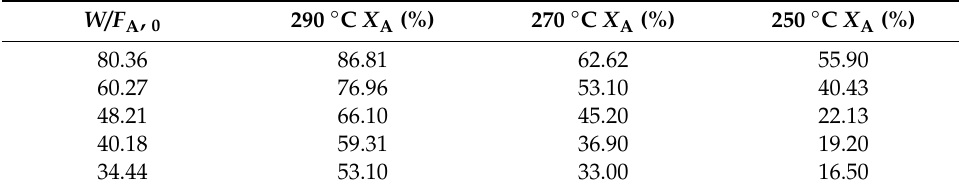
Table 2. Experimental dynamic data.